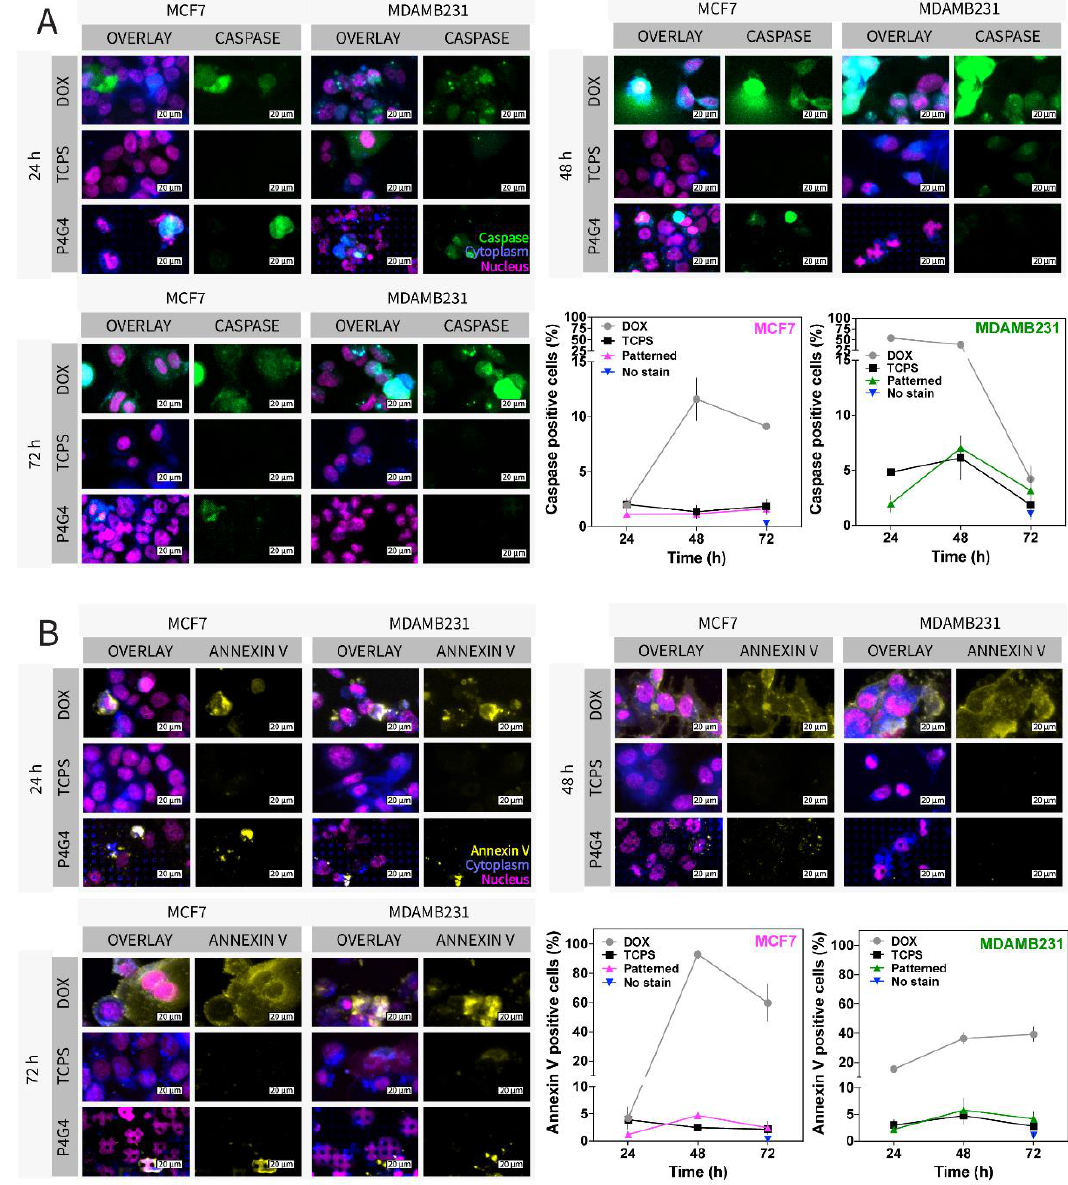
Figure 4. Apoptosis assay of MCF7 and MDAMB231 cells on Ch-Pattern and TCPS. ( A ) Caspase 3/7 activity of the cells was detected using CaspaTag (FAM-DEVD-FMK) on Ch-Pattern, and doxorubicin was used as the inducer of apoptosis (positive control) and TCPS as negative control (Scale bar: 20 µ m, green: Caspa-Tag-Caspase 3/7, blue: CellTracker-Cytoplasm, and pink: Hoechst). Caspase-positive cell percentage was calculated from caspase-positive cells and the total number of cell nuclei (two-way ANOVA, MCF7: p time = 0.0013, p sample < 0.0001, MDAMB231: p time < 0.0001, p sample < 0.0001, see Supplementary Figure S7). ( B ) Annexin V protein on the surface of the cells was detected using Annexin V antibody on Ch-Pattern, and doxorubicin was used as the inducer of apoptosis (positive control) and TCPS as negative control (scale bar: 20 µ m, yellow: Annexin V, blue: CellTracker-Cytoplasm, and pink: DAPI). Annexin-positive cell percentage was calculated from Annexin V-positive cells and the total number of cell nuclei (two-way ANOVA, MCF7: p time = 0.0014, p sample < 0.0001, MDAMB231: p time < 0.0001, p sample < 0.0001, see Supplementary Figure S8).